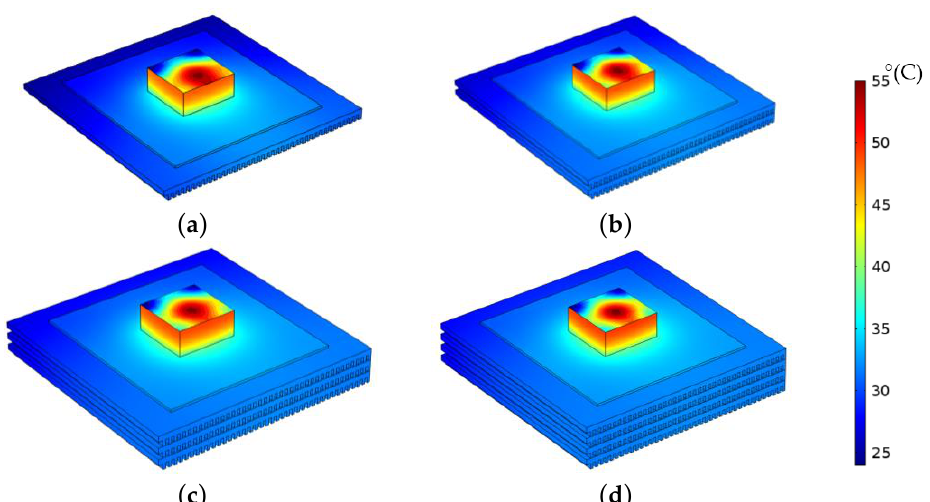
Figure 11. The MLM heat sink isotherms of 30 mL/min HTF flow rate and 15 W power rate for ( a ) one-layer; ( b ) two-layers; ( c ) three-layers; ( d ) 4-layers.